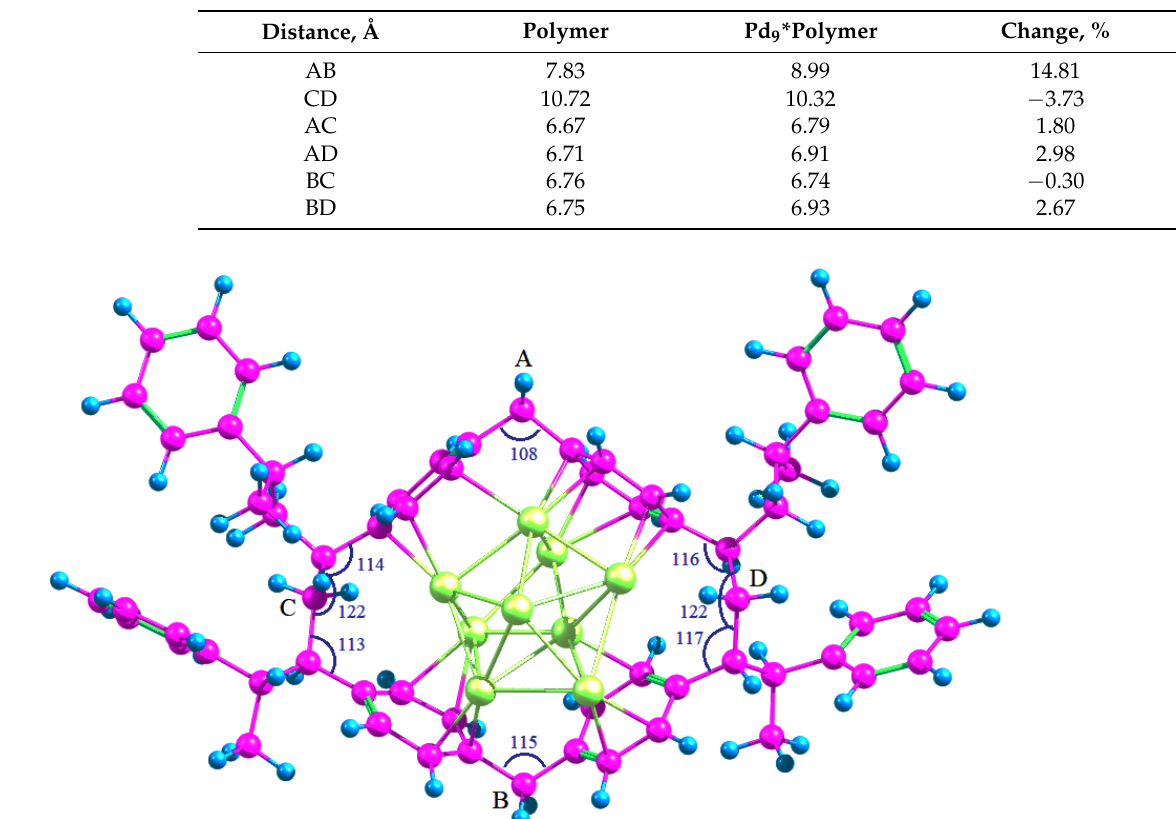
Figure 5. Optimized geometry of Pd 9 incorporated into the HPS micropore.